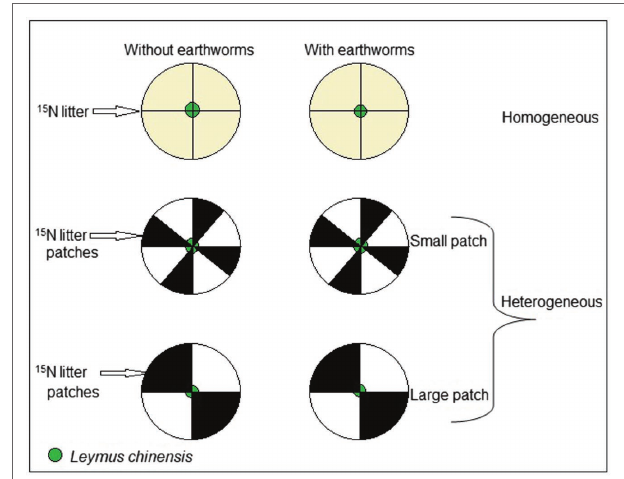
FIGURE 1 | Schematic representation of the experimental design. The experiment consisted of three soil treatments (homogeneous vs. heterogeneous small patch vs. heterogeneous large patch) crossed with two earthworm treatments (with vs. without Eisenia fetida ). The heterogenous treatments consisted of high-quality patches with 15 N-labeled litter and low- quality patches without the litter and the homogenous treatments were a even mixture of the high- and the low-quality patches; thus, the nutrients and substrate were exactly the same at the whole pot level for all treatments. Each pot was divided into four large patches (quadrants) in the large patch treatments and eight small patches in the small patch treatments. A mother (initial) ramet of Leymus chinensis were grown in the middle of each